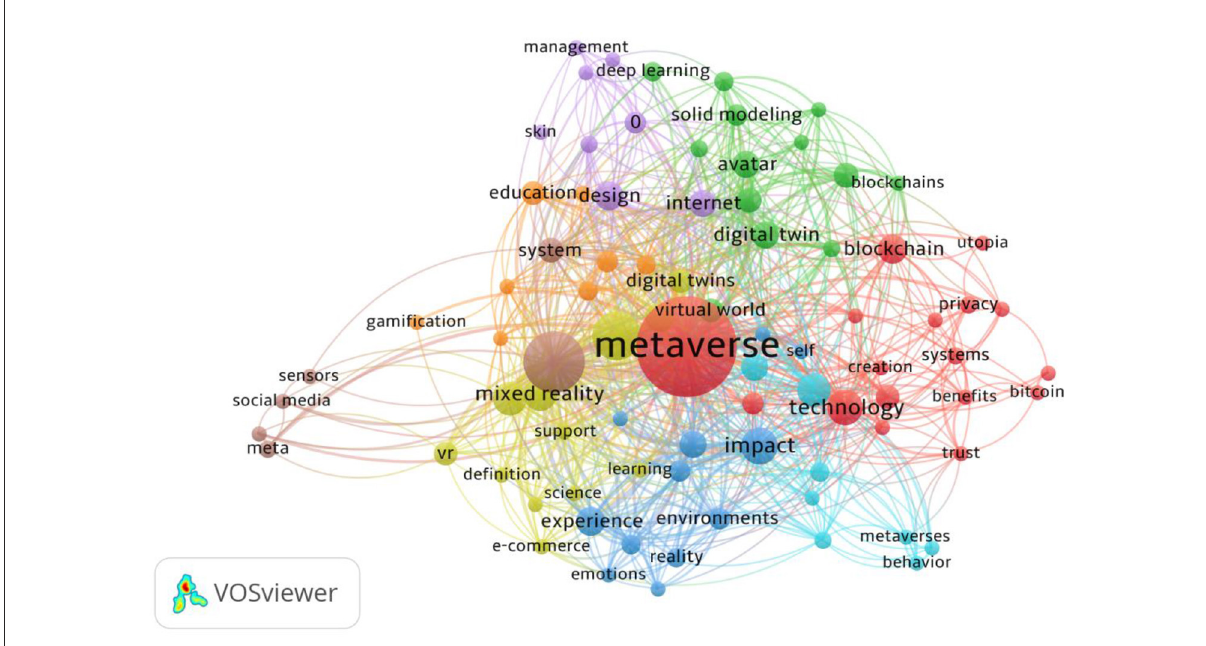
FIGURE1 Clustering keywords related to the metaverse-based